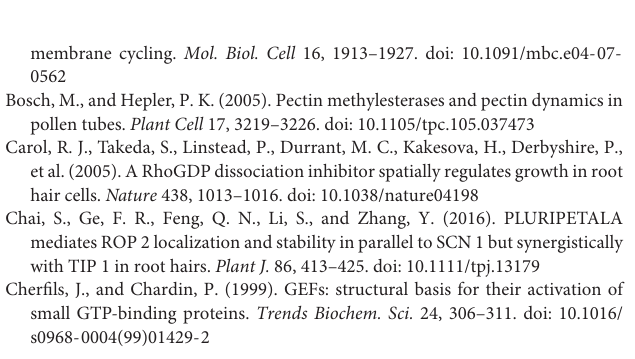
Supplementary Figure 1 | Transmembrane domain analysis of OsRopGEF3 , OsRac3 , and OsRBOH5 . Supplementary Figure 2 | Fluorescence intensity comparison of ROS staining. Supplementary Figure 3 | Identification of OsRac gene expression using qRT-PCR. Supplementary Figure 4 | Induction of plasmolysis in tobacco leaf epidermal cells by treatment with 1M NaCl. OsRopGEF3-eGFP and OsRac3-eGFP were individually transiently expressed in cells. Supplementary Figure 5 | Transient expression pattern of p35S-eGFP (empty vector) in tobacco leaf cells. Supplementary Table 1 | Primer sequences used in this